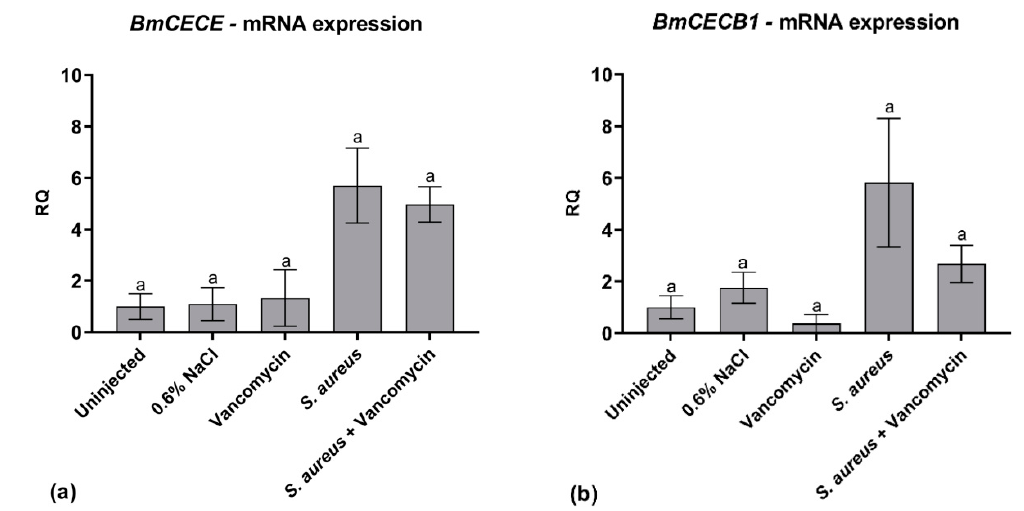
Figure 6. Quantitative reverse transcription PCR (qRT-PCR) analysis of BmCECE ( a ) and BmCECB1 ( b ). mRNA levels in control larvae (uninjected larvae and larvae injected only with physiological solution) and in healthy and infected larvae treated and untreated with vancomycin (8.75 µ g / g body weight). Values represent mean ± s.e.m. Different letters indicate statistically significant differences among treatments ( p < 0.05).